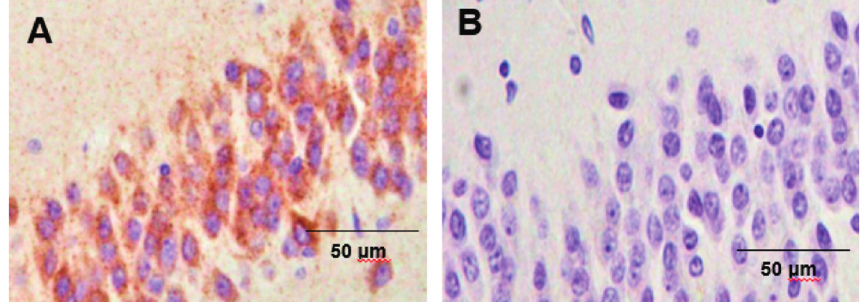
Figure 6: (Pro)renin receptor staining in the granular layer of the hippocampus with (B) or without (A) the human (pro)renin receptor fragment as a blocking peptide. The specificity of the (P)RR antibody used was confirmed.